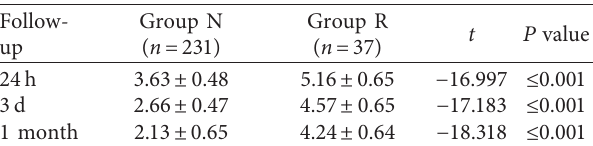
Figure 7: Distribution characteristics of spongy bone cement. (a) Anteroposterior X-ray film of diffuse distribution pattern in the spongy group. (b) Lateral X-ray film of diffuse distribution pattern in the spongy Table 1: Summary of VAS after surgery between group N and group R.